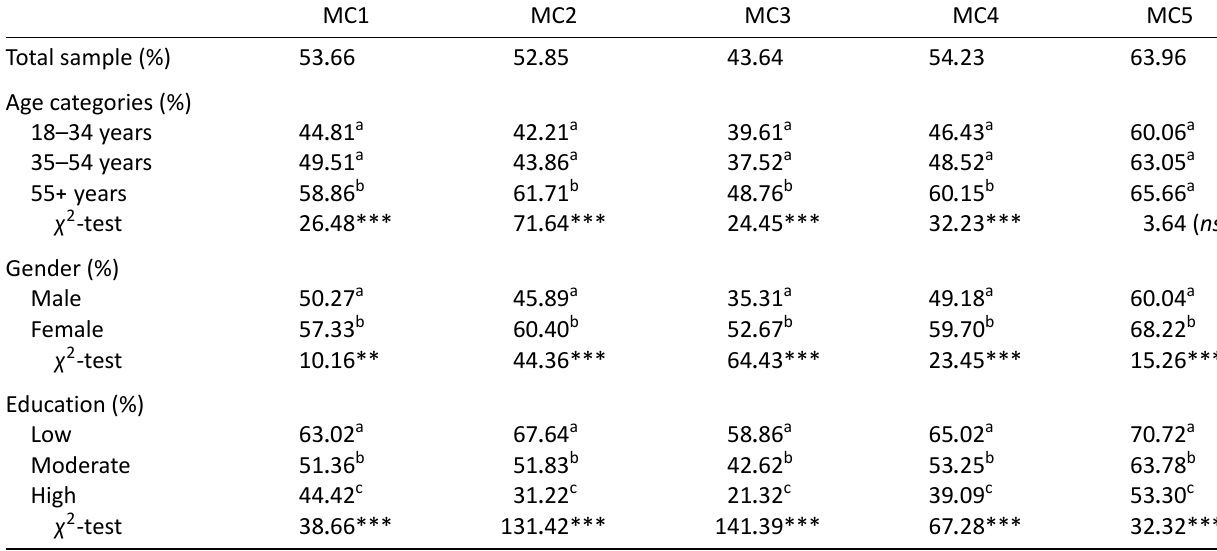
Table 2. Percentage of people giving an incorrect answer on the misconception items.